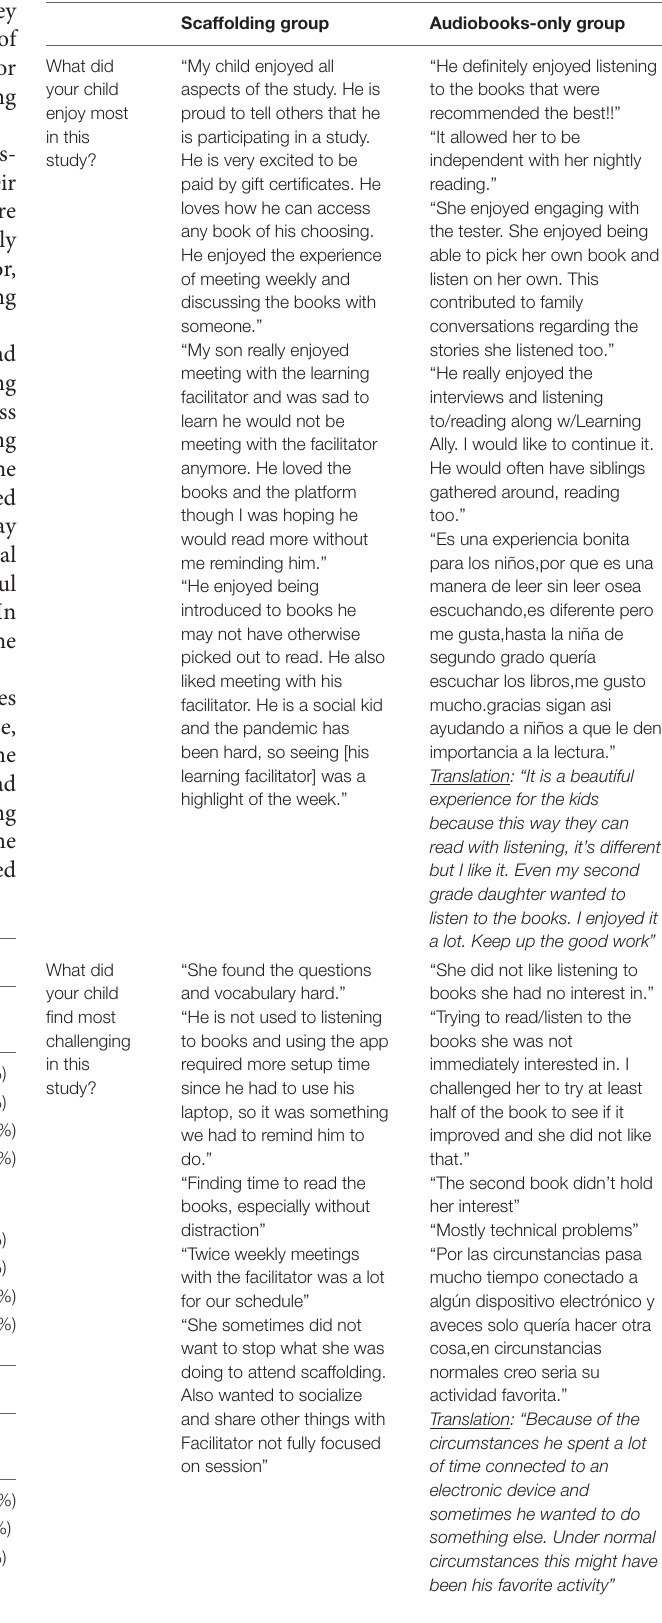
TABLE 8 | Caregiver experiences in scaffolding and audiobooks-only